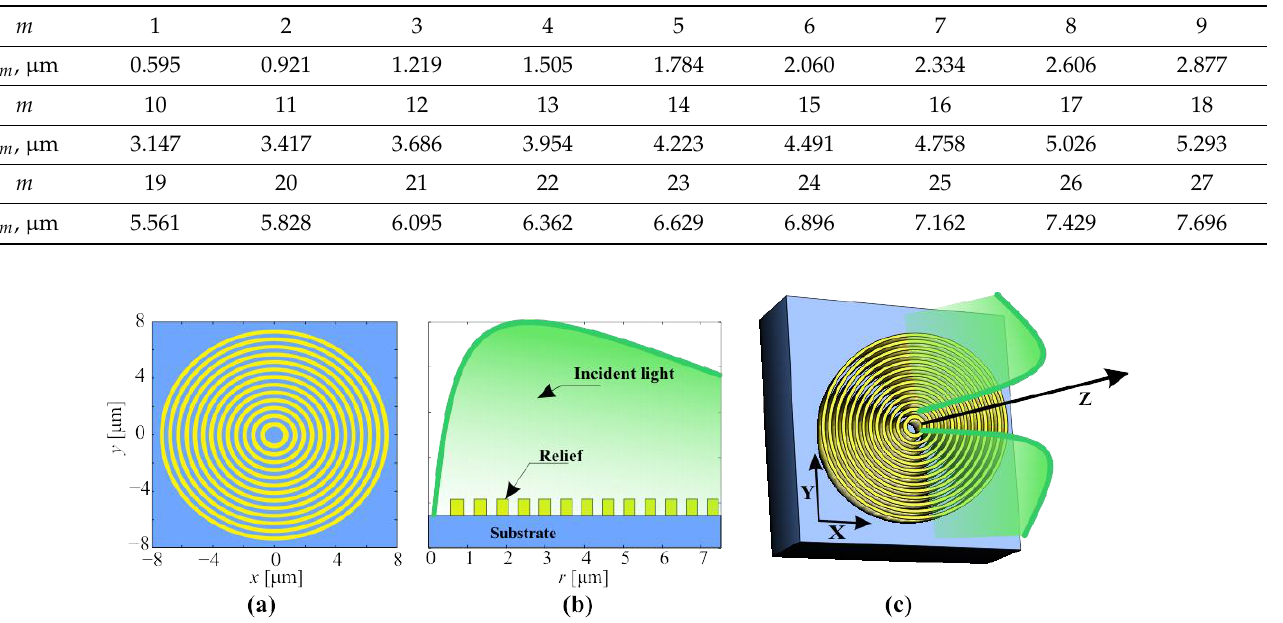
Table 1. Radii of BZP’s zones.